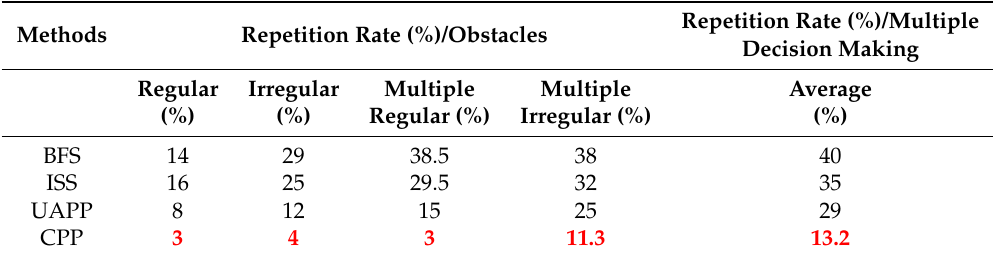
Table 8. A comparative analysis of the repetition rate in traversing the operational